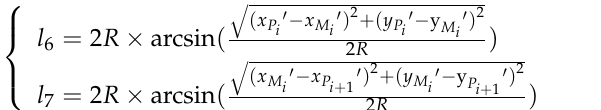
D is equal to the minimum is equal to the minimum i (cid:48) P i + 1 + ′ 1 i i O P ∠ ≤ , ( b ) is the sche- 90 OPP + 1 i i i ∠ > , the red line is the calculated shortest route. 90 OPP + 1 i i i